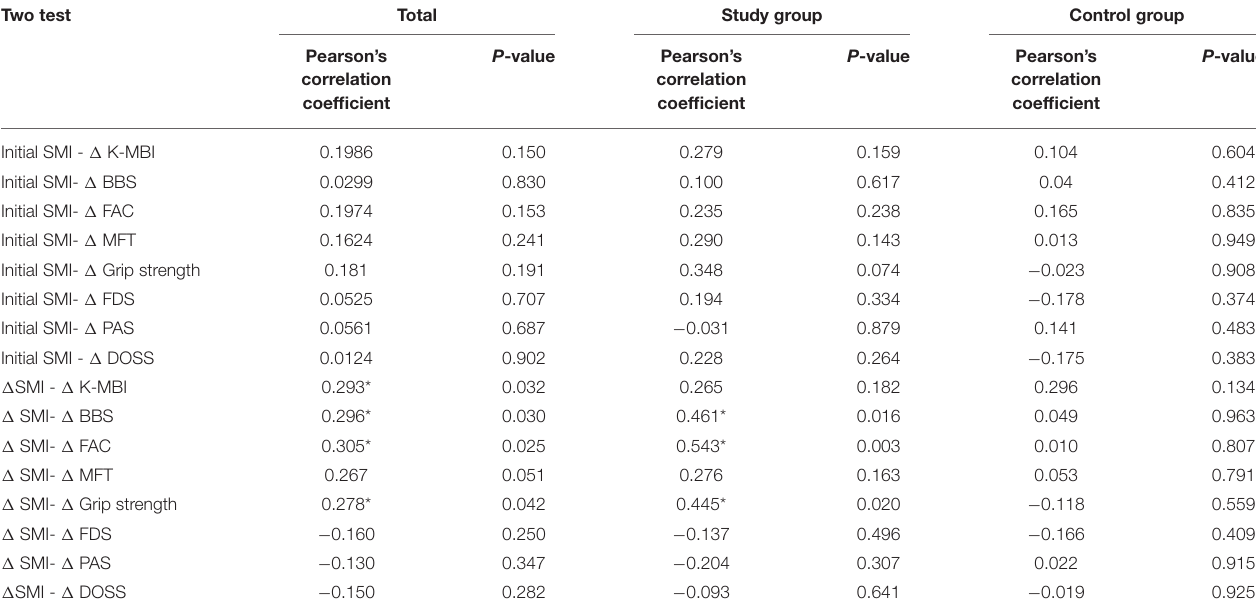
TABLE 3 | Pairwise correlations between function and sarcopenia status. Two